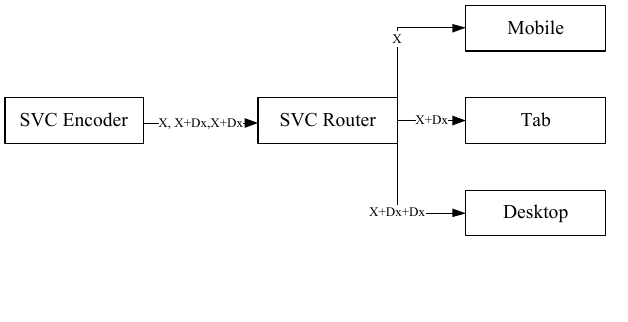
Figure 4 . SVC Streaming